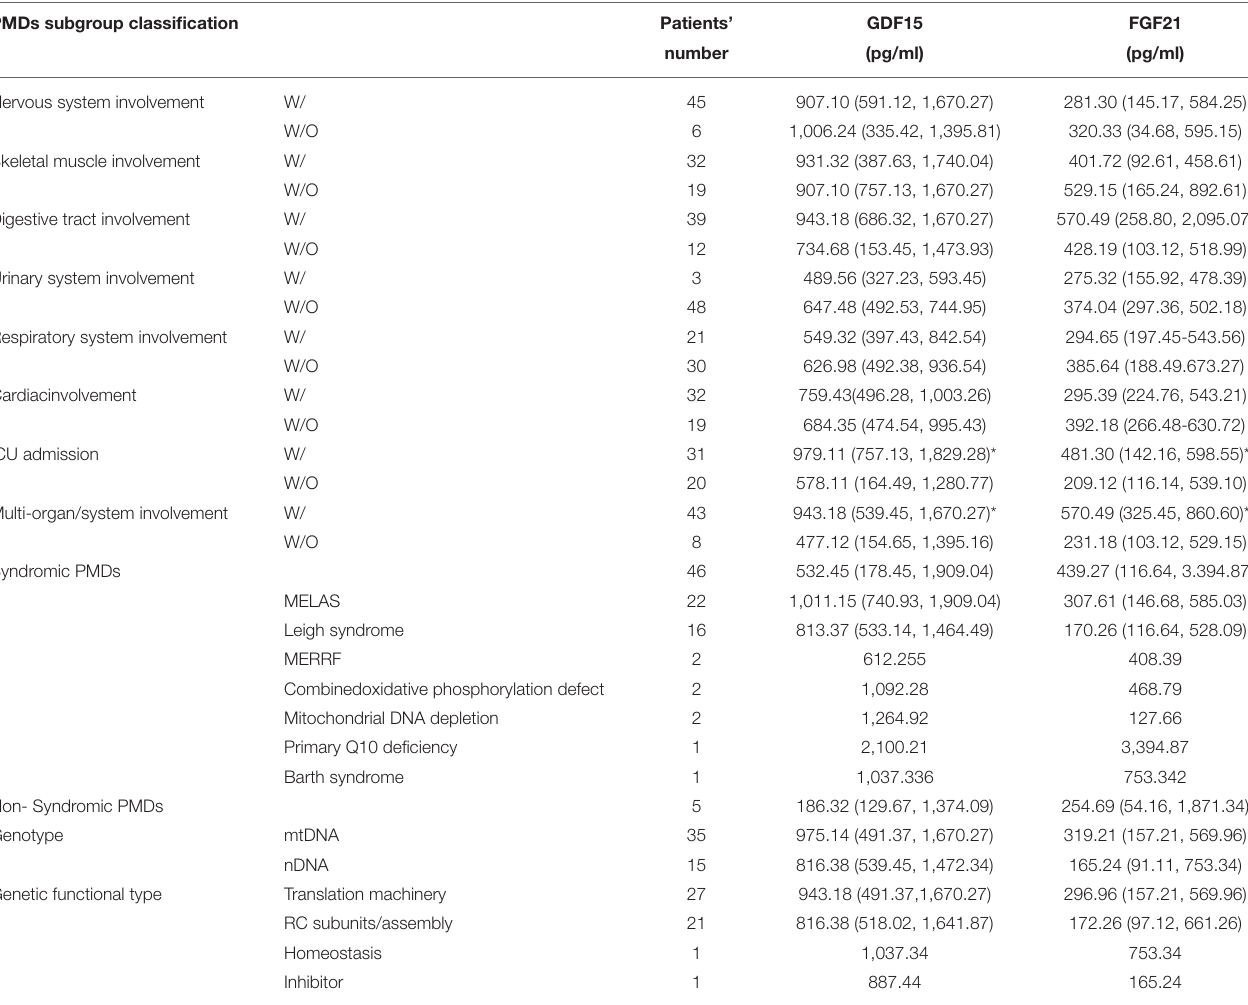
TABLE 2 | FGF21 and GDF15 in the primary mitochondrial disorder (PMD)